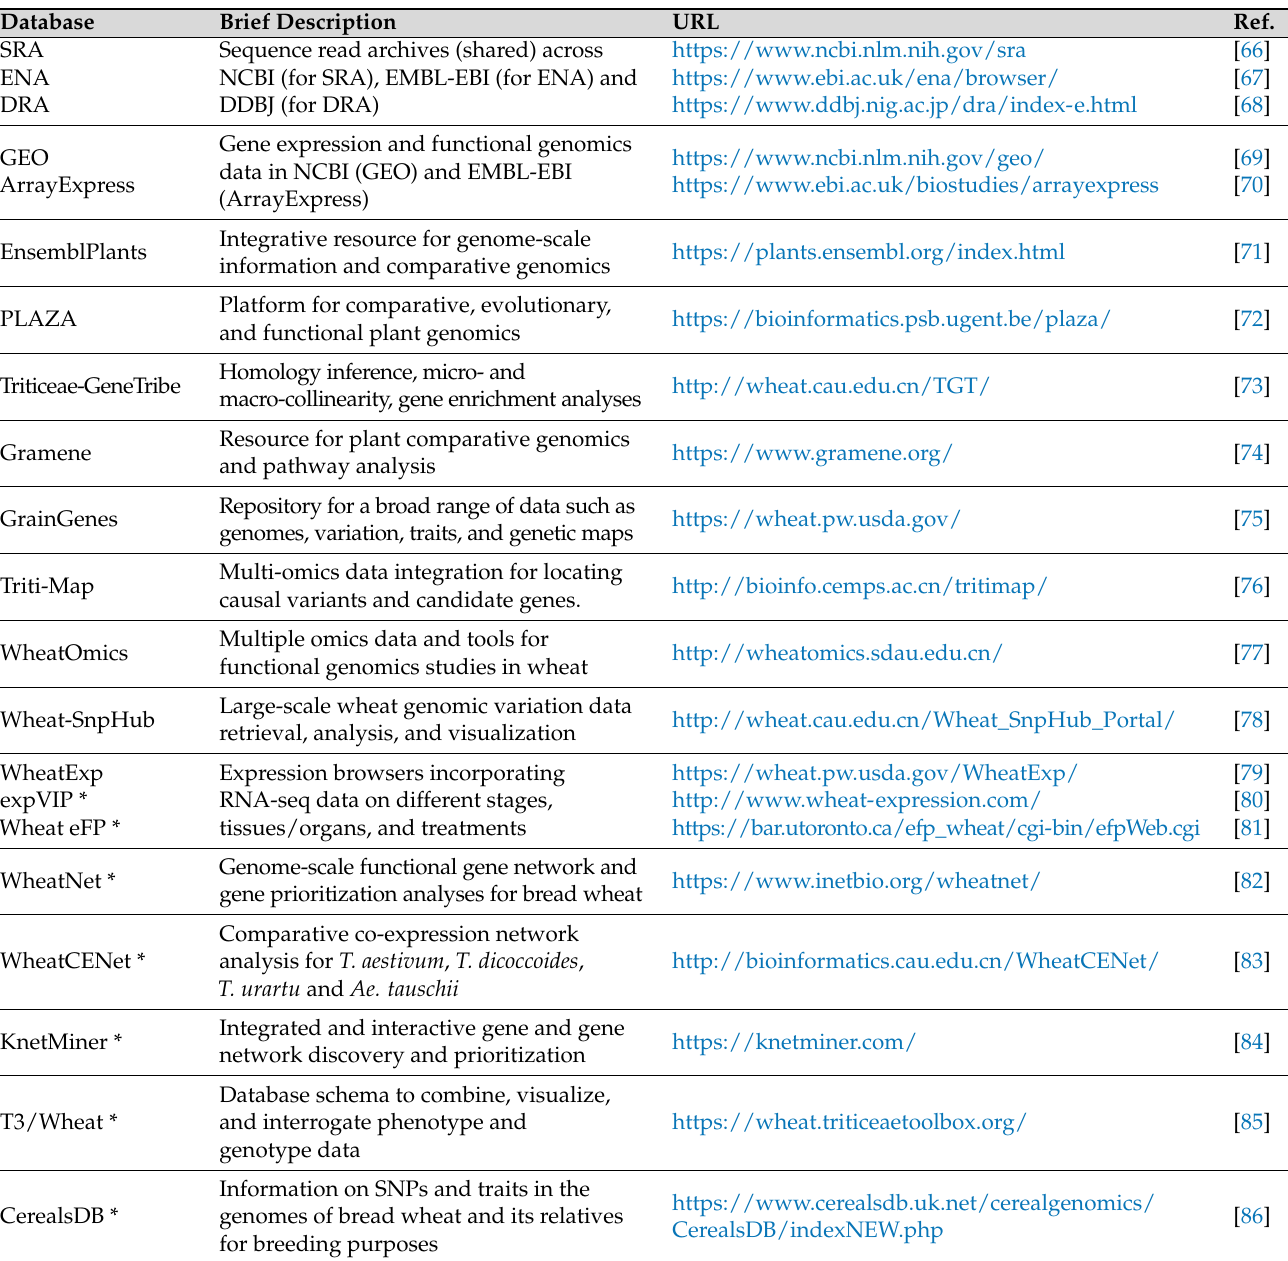
Table 2. Relevant databases for durum wheat research in transcriptomics and functional genomics. URL access date for all databases was 20 February